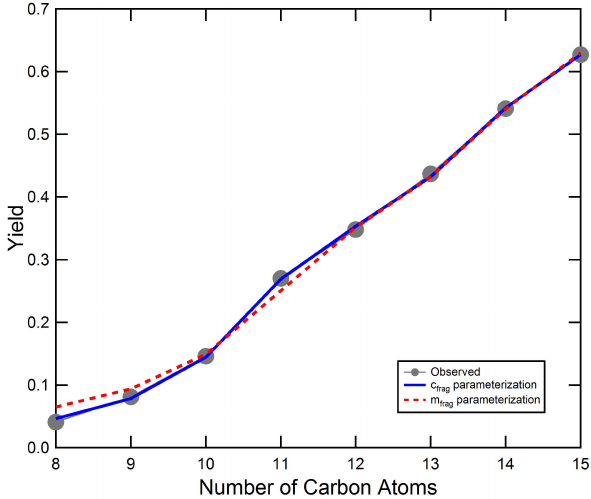
Fig. 11. Calculated N C -dependent yields for straight-chain alka- nes of varying N C compared with observed yields from Jordan et al.